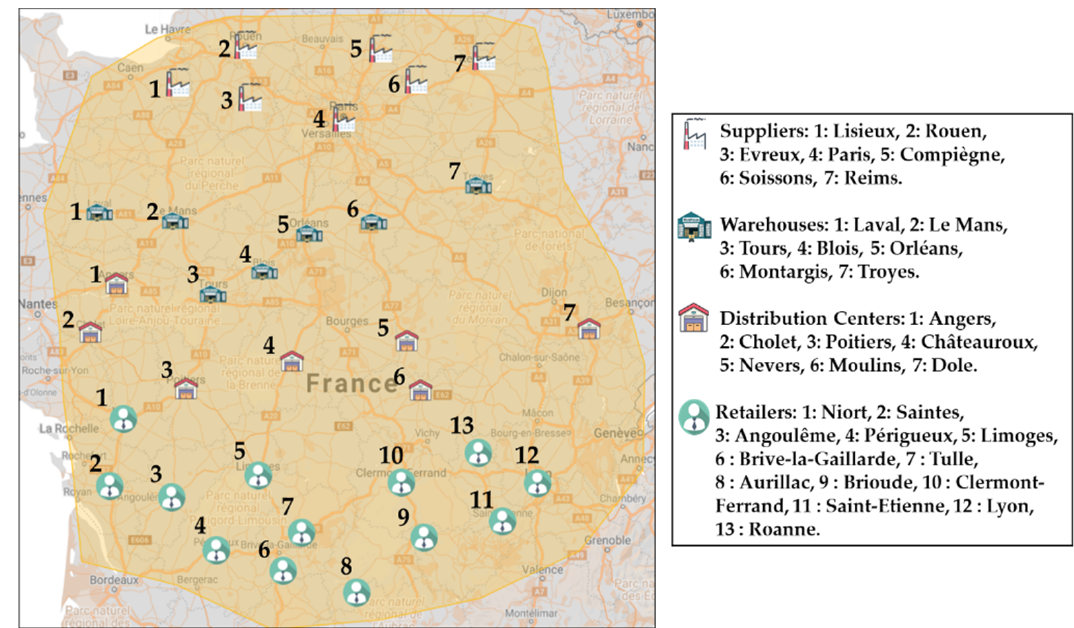
Figure 9. Used distribution network.